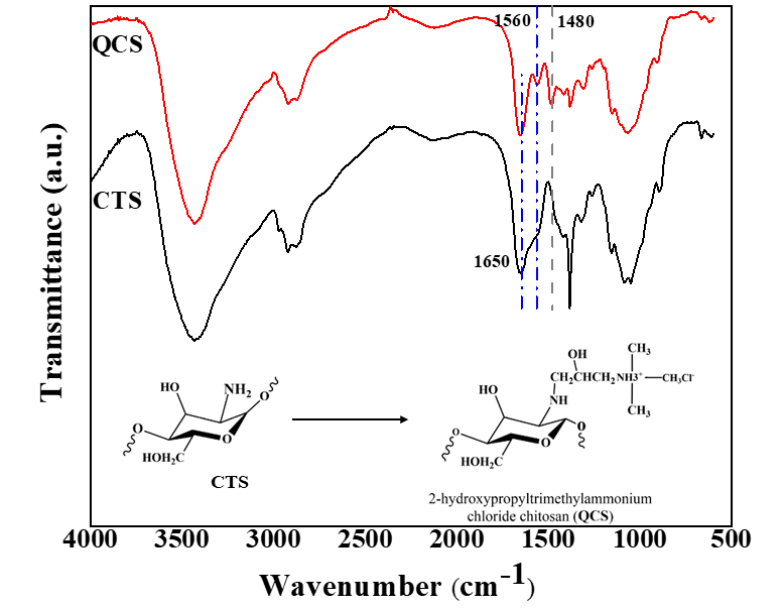
Figure 5. FTIR spectra of chitosan and quaternized chitosan .